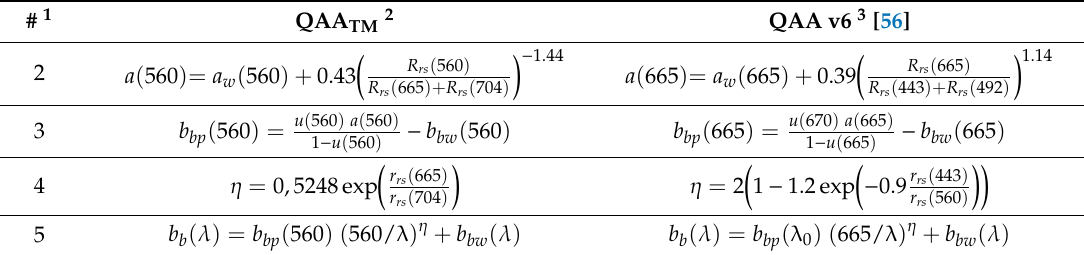
Table 5. Summary of QAA TM and comparison with original QAAv6.